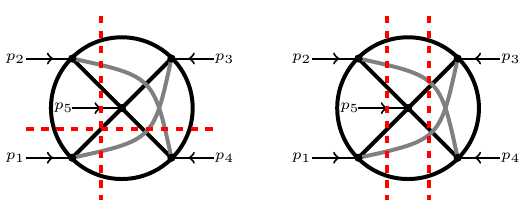
Figure 2 . Loop topologies with ( left :) two overlapped and ( right :) two entangled thresholds.